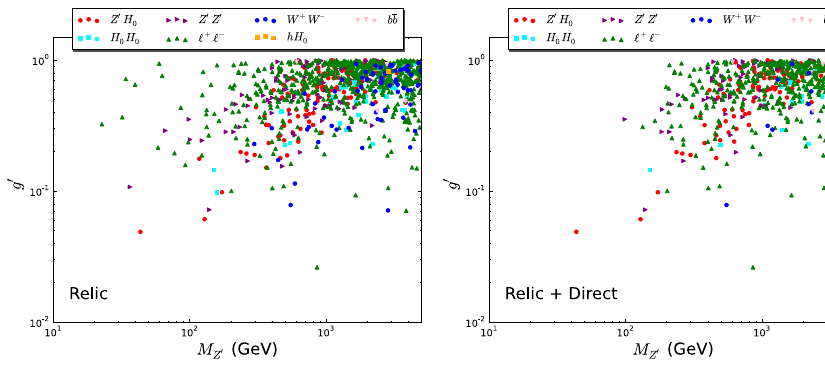
Fig. 1 Distribution of dominant annihilation channels in the g (cid:3) - M (cid:3) plane. Survived Z samples in left panel satisfy constraints from relic density, while those in right panel satisfy constraints from both relic density and direct